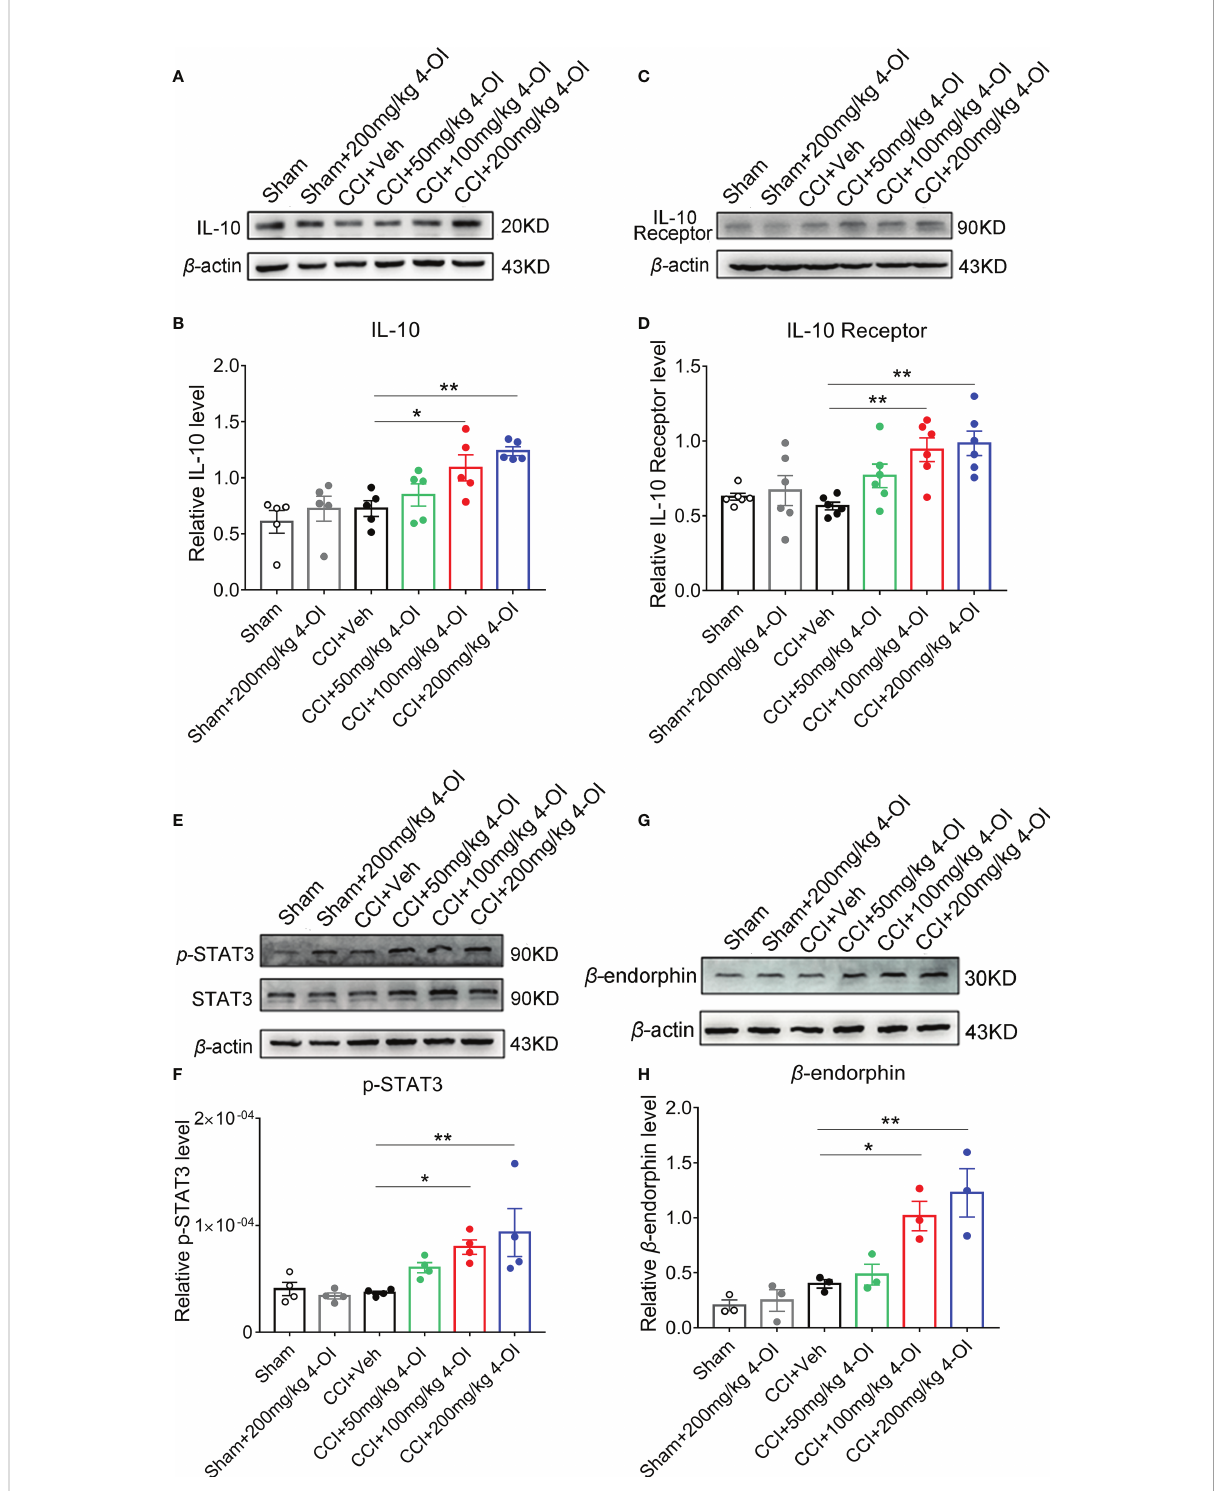
FIGURE 7 4-OI activated the IL-10/ b -endorphin pathway. At 14th days post injury, different doses of 4-OI were applied to CCI mice by intraperitoneal injection. Compared with the vehicle group, the expressions of IL-10 (A, B) , IL-10 receptor (C, D) , p-STAT3 (E, F) and b -endorphin (G, H) in ipsilateral spinal cord of CCI mice were elevated at 2 hours post 100 and 200 mg/kg 4-OI application. Data are presented as mean ± SEM. ** p <0.01, * p <0.05 vs. CCI + Veh, followed by One-way ANOVA with Dunnett ’ s multiple comparisons test (n =